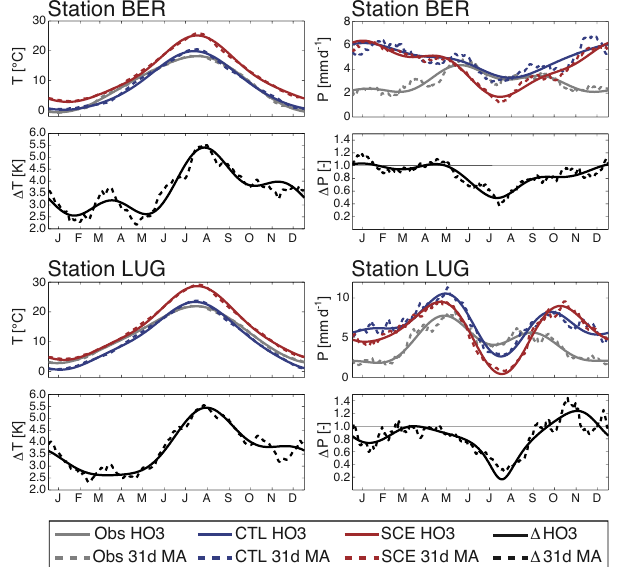
Fig. 4. Comparison between annual cycles estimated by a 31d MA (dashed lines) and a third order harmonic smoothing (HO 3; solid lines). Annual cycles of T and P are displayed in the left and right panels respectively. Results of the model chain ETHZ-HadCM3Q0- CLM at the two exemplary stations BER (top) and LUG (bottom) are shown. In each of the four blocks, the top panels contain the annual cycles in the CTL period 1980–2009 and SCE period 2070– 2099. The annual cycles of the observed records in the CTL period are added in grey. In the bottom panels, the delta change signals are shown.